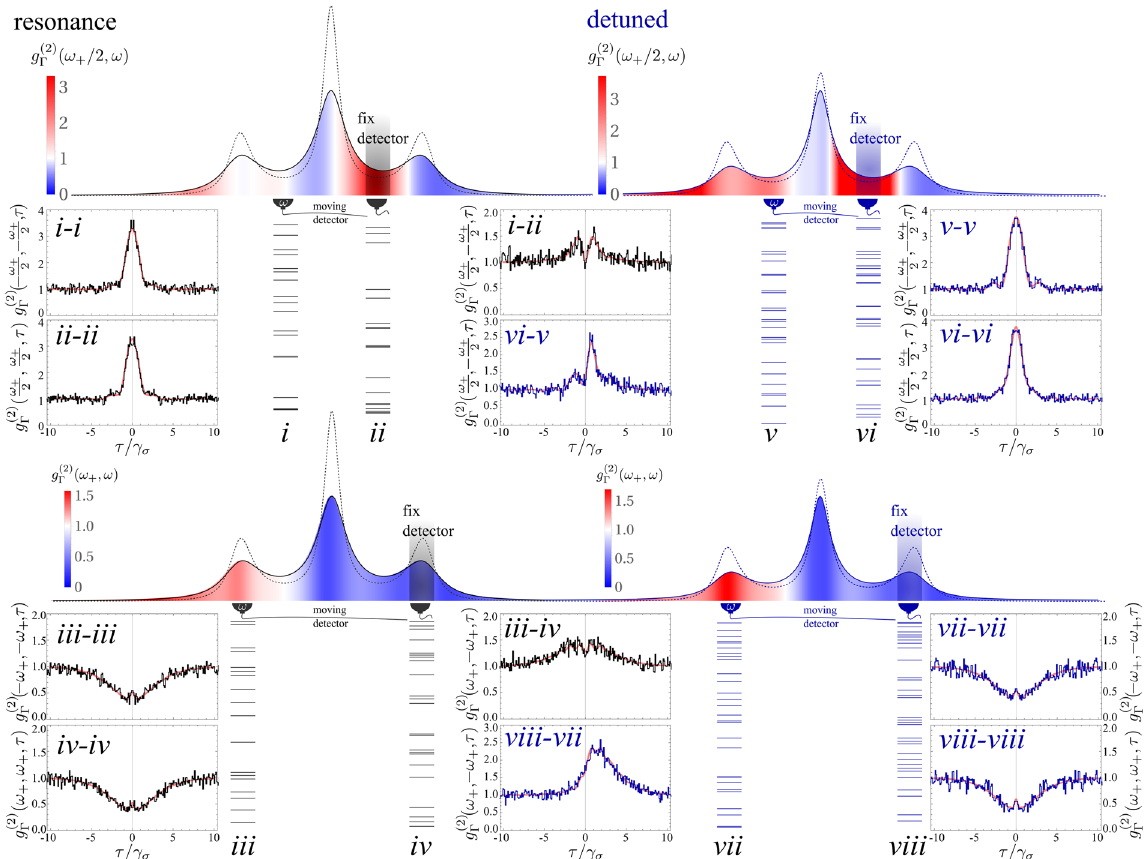
Figure 8. Frequency-resolved Monte Carlo simulation of the Mollow triplet in dual frequency windows. The case on the left (right) is for driving the two-level system at resonance (with detuning Δ = 1.5 γ σ ). The dotted (solid) lineshape is the triplet as detected by an ideal (finite-bandwidth Γ ) detector. The color code within the spectra is for one filter kept fixed at a leapfrog window (top case) or at a sideband (bottom case). Sequences of clicks have been recorded in the windows i and ii and iii and iv , the two groups being independent (that is, clicks between, e.g, i and iii are not correlated). Small samples are displayed, with renormalization of time to compare equal intensities between the two groups (time is the same within each group). Strong correlations of photons with different frequencies are clear, in particular, the simultaneity of leapfrog emission and their heralding character with detuning are obvious. The cross-correlations are shown as measured by the Monte Carlo data (left column) and as computed by the theory of frequency-resolved photon correlation (2nd column, red). 1/ γ σ sets the unit, Ω = 5 γ σ , Δ = 1.5 γ σ and Γ = γ σ . The clicks correspond to the emission events of the operators c 4 and c 5 in Eq.